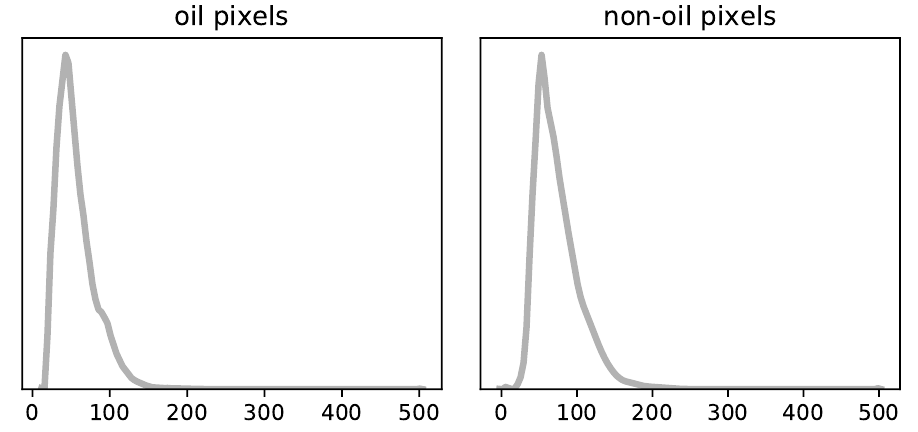
Figure 1. Distribution of the backscatter values in the VV images, across pixels belonging to class “oil” and “non-oil”. The plots show only the range [ 0,500 ] , rather than [ 0,2 16 ] . As we can see from the plots, the backscatter distribution is shifted toward small values in the interval. As expected, the backscatter distribution of oil-covered pixels is shifted towards values that are lower than non-oil pixels. Based on this analysis, we clip the maximum value in all VV images in pixels have a backscatter value lower than